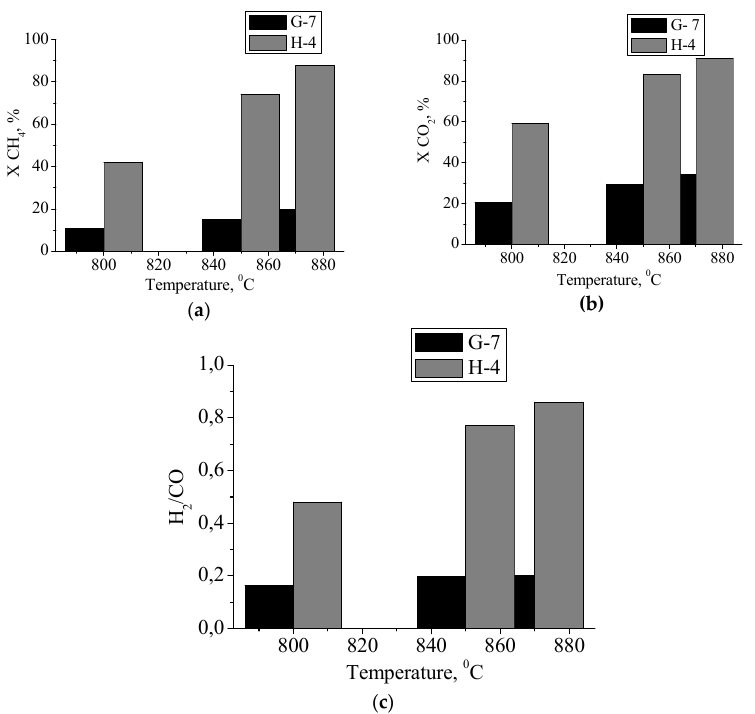
Figure 10. Effect of the phase composition of the catalyst on ( a ) CH 4 conversion, ( b ) CO 2 conversion, and ( c ) H 2 /CO ratio for dry reforming of methane. For all experiments, the flow rate of the gas mixture was 30 cm 3 /min and the contact time was 0.6 s.